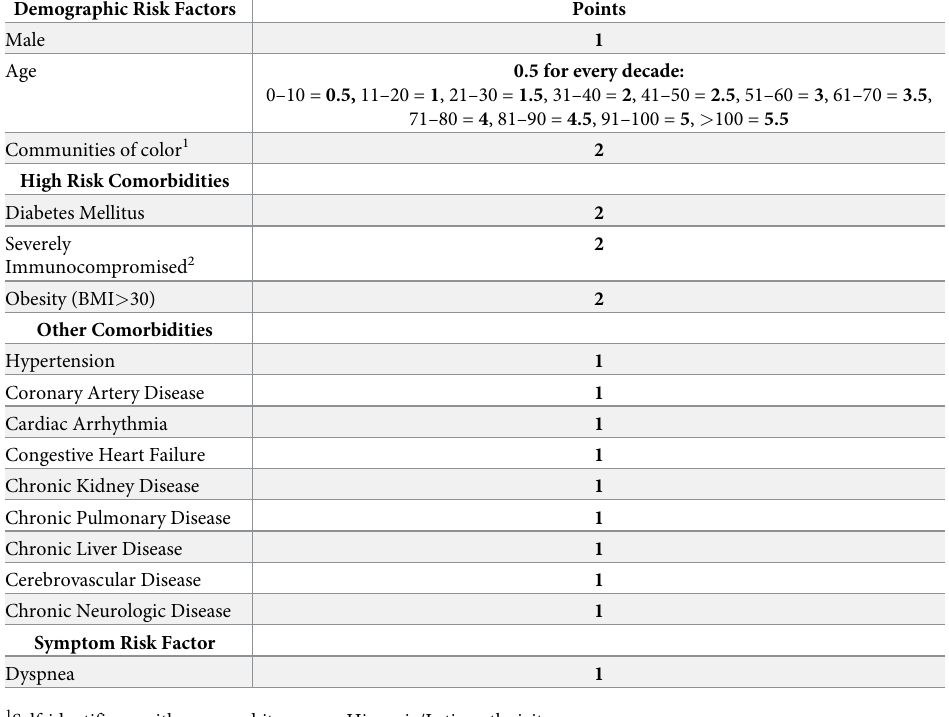
Table 6. Simplified clinical prediction score for COVID-19 outcomes.